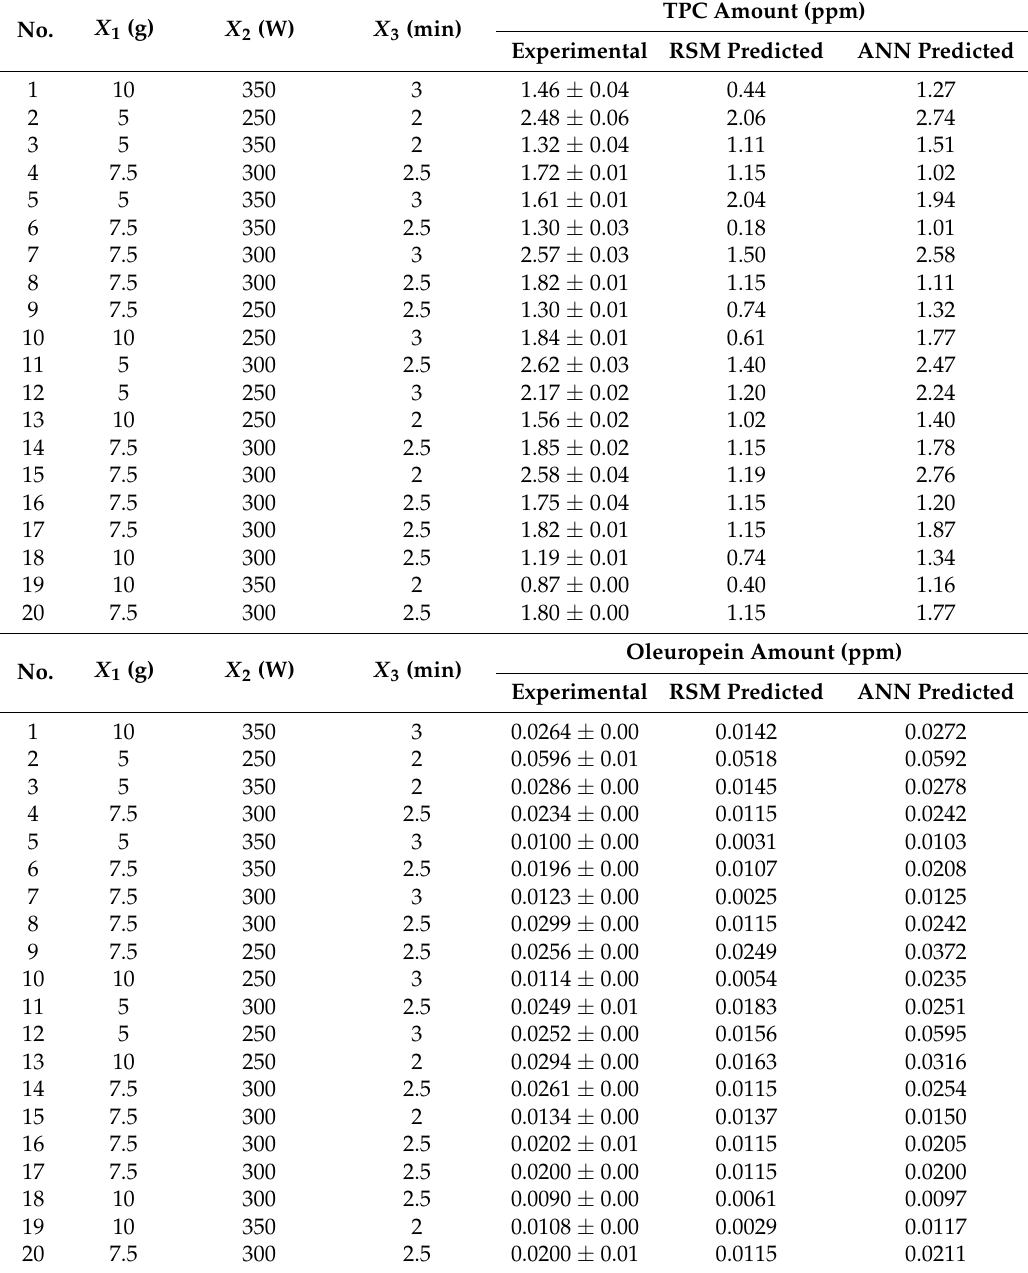
Table 1. A comparison between the experimental and predicted values obtained for TPC and oleuropein yields after solvent-free microwave-assisted extraction using response surface methodology (RSM) and artificial neural networks